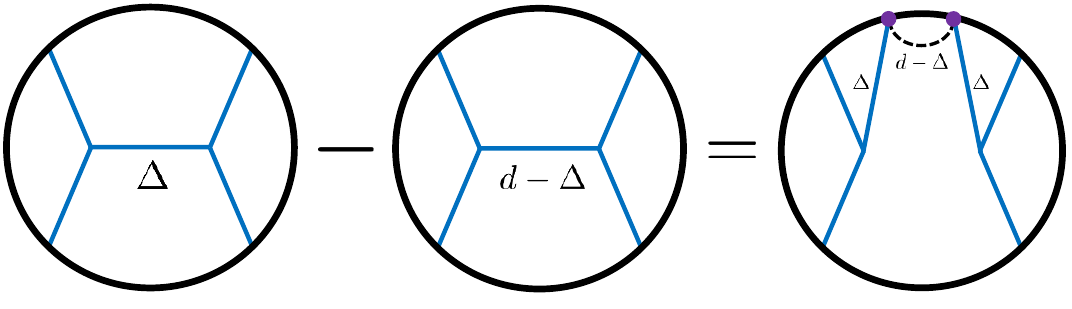
Figure 4 . The AdS dual of the two-triangle diagram in CFT. The di(cid:11)erence of two exchange diagrams with external (cid:8) (cid:12)elds | one with standard quantization ((cid:1)) of the (cid:12)eld dual to O , and one with alternate quantization ( d (cid:0) (cid:1)) | can be written, using the split representation of the AdS harmonic function, as a pair of boundary three-point functions tied together by a boundary two- point function of dimension d (cid:0) (cid:1). This is manifestly equivalent to the two-triangle diagram in